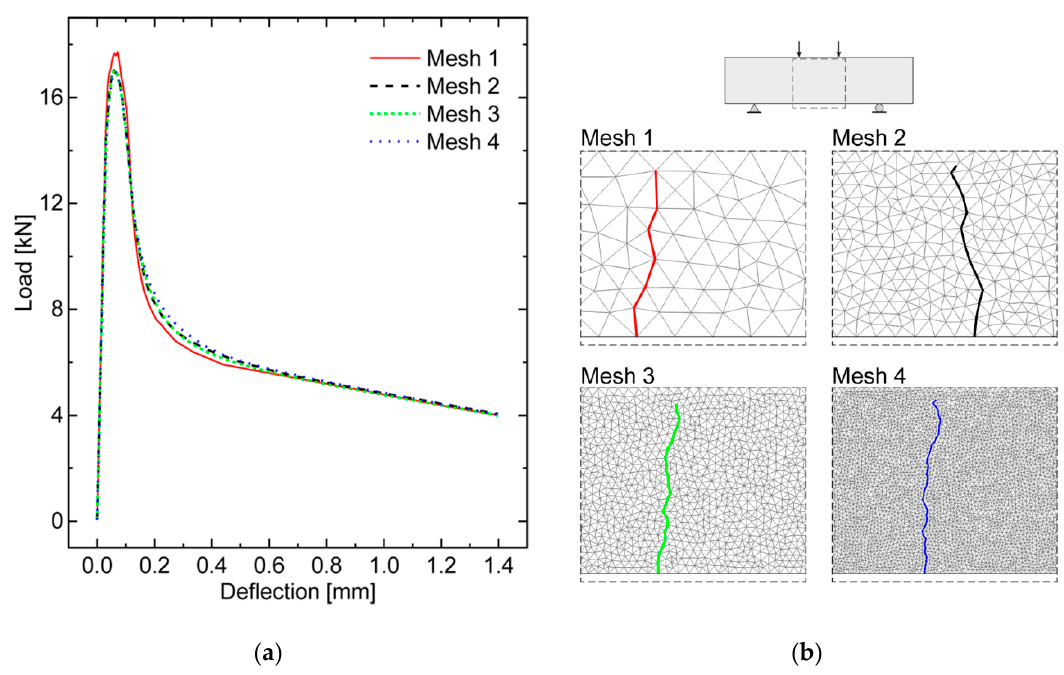
Figure 6. Global structural response of the control UHPFRC beam for different mesh sizes: ( a ) load versus mid-span deflection curve; ( b ) main flexural crack path within the cohesive region.